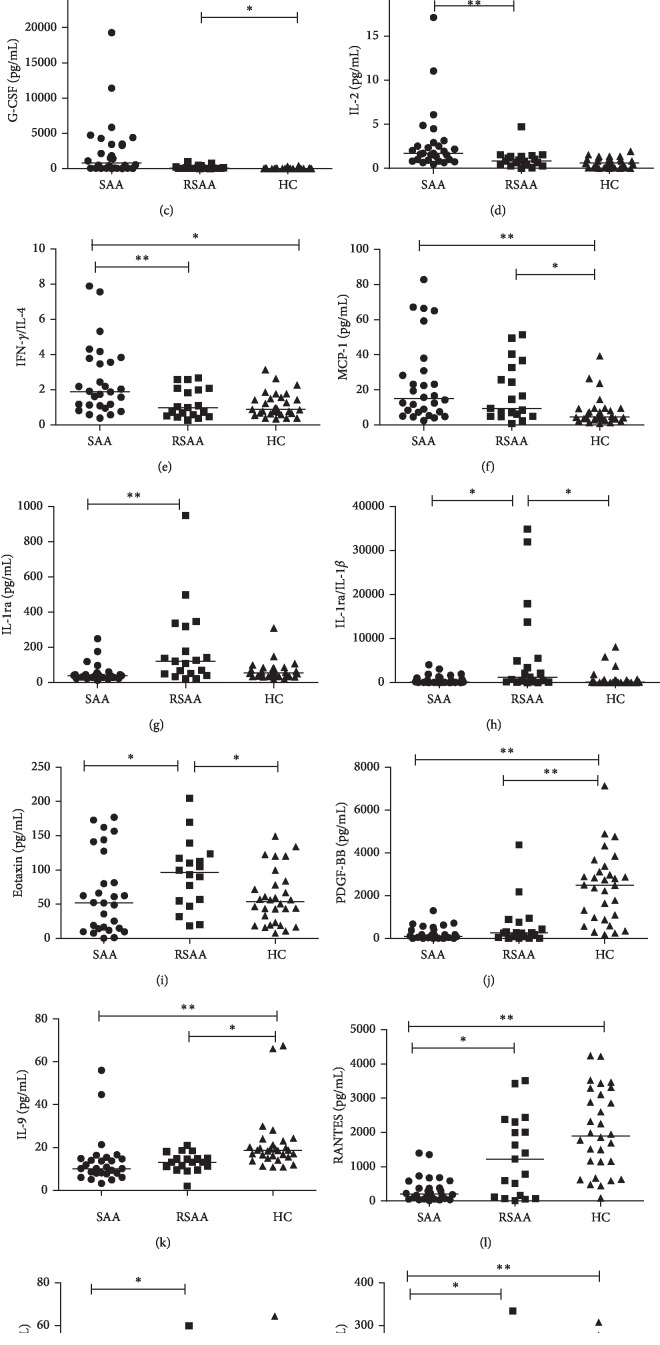
Levels of cytokines and growth factors in the BMP of SAA patients, RSAA patients, and HCs. The bars represent median values. A rank-based Kruskal-Wallis one-way analysis of variance (ANOVA) was performed to test for differences in the concentrations of cytokines among SAA patients, RSAA patients, and HCs. SAA: severe aplastic anemia; RSAA: recovering SAA; HC: healthy control; ∗∗p < 0.01, ∗p < 0.05.